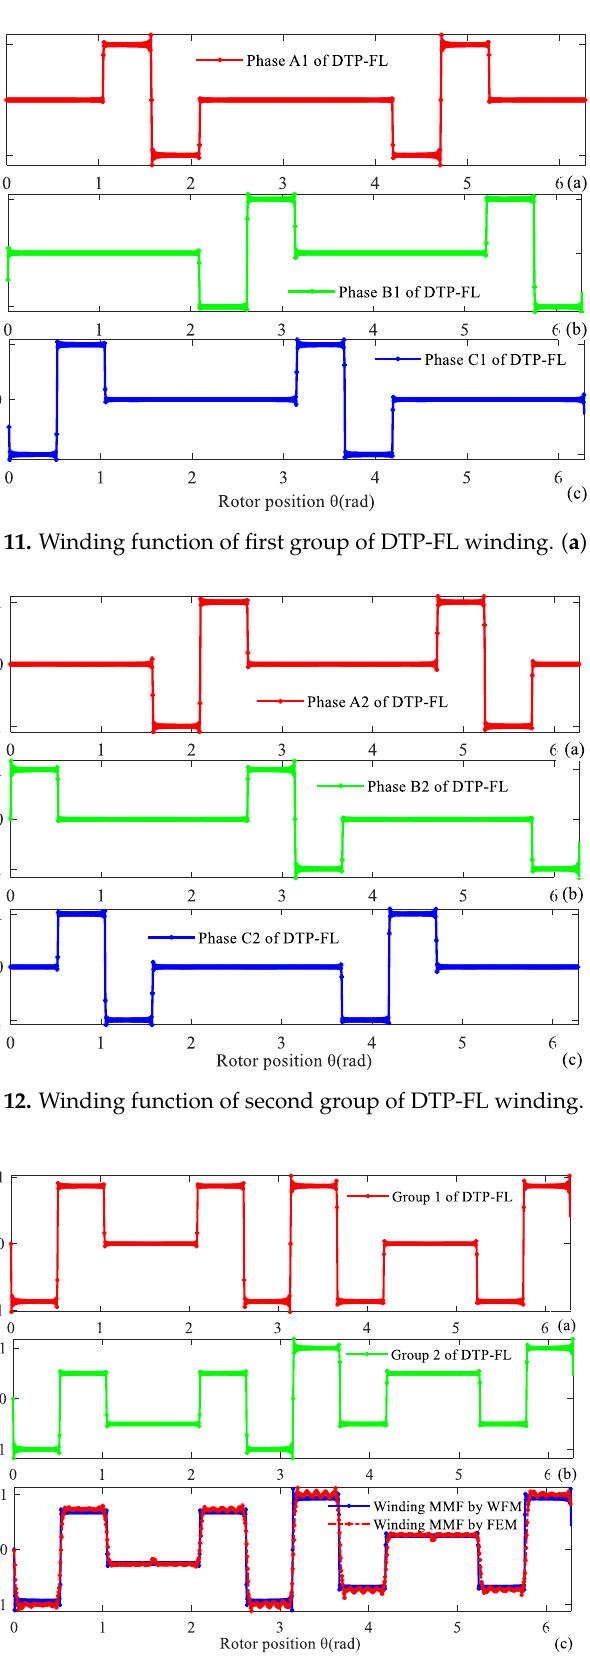
MMF of DTP-FL winding is also validated by FEM as shown in Figure 13.